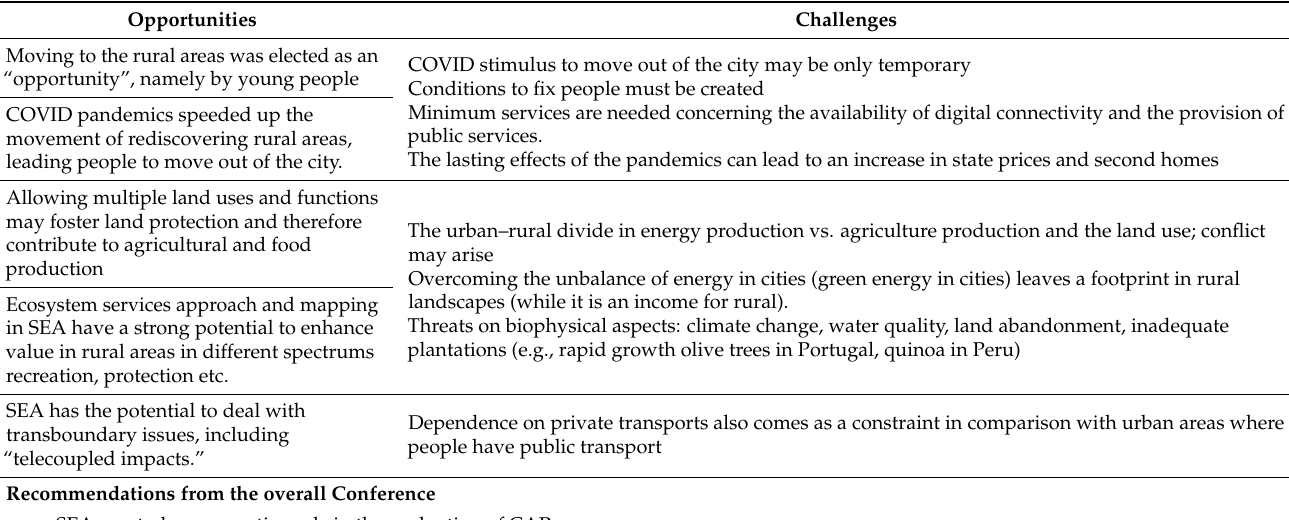
Table 2. Summary of stakeholders views on strategic challenges and opportunities for agriculture and rural development in Europe and the potential role of SEA. Source: author’s